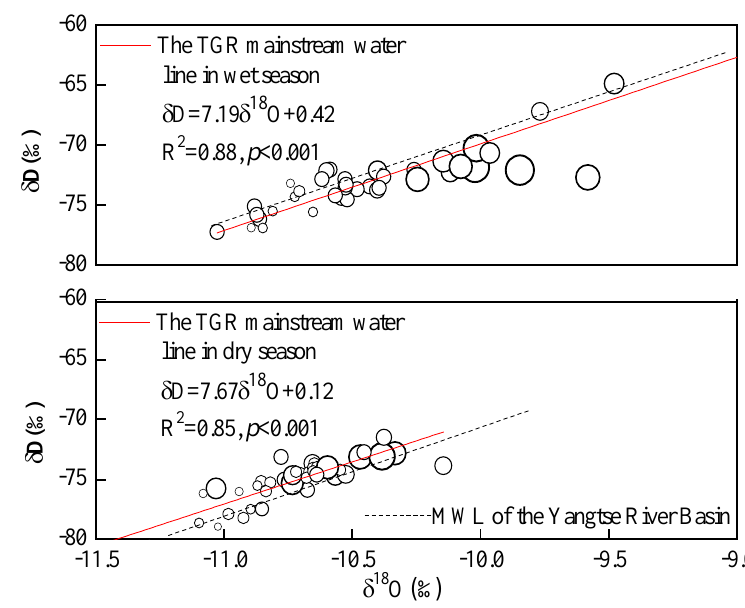
Figure 4. Correlations between δD and δ 18 O of the TGR in the wet and dry seasons ( n = 114). MWL of the Yangtse River Basin: Meteoric Water Line of the Yangtse River Basin [11]. The bigger the size of point’s figure is, the closer the sampling point is to the TGD.